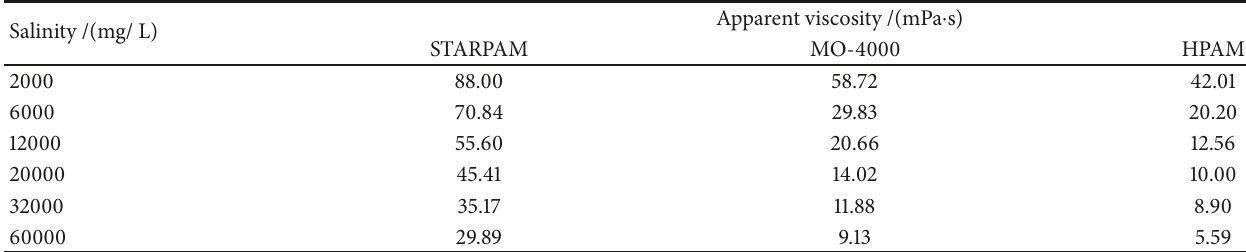
Table 4: Comparison of the influence of polymers viscosity on the salinity.